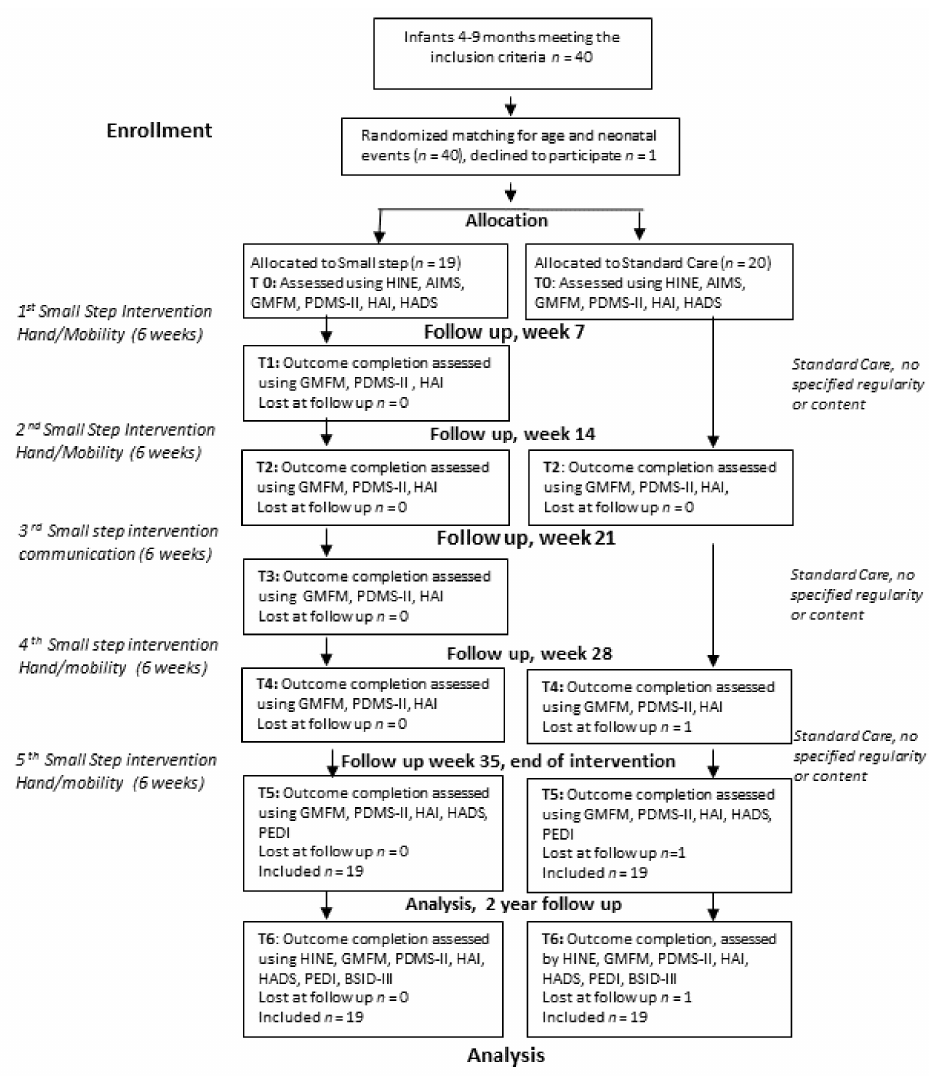
Figure 1. Flow diagram of data collection